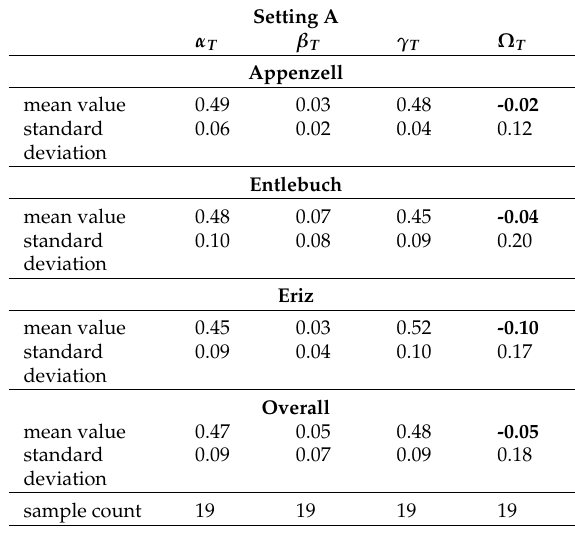
Table 3. Evaluation results for setting A . α T denotes the simulation performance related to the overlap (a value of 1 corresponds to full coverage of simulation/observed). β T is a performance measure of the underestimation, whereas γ T shows the overestimation performance of the considered simulation. The overall performance is specified by Ω T . All values are calculated based on Equation (6), following the procedure described in Heiser et al. [43]. Setting A α T β T γ